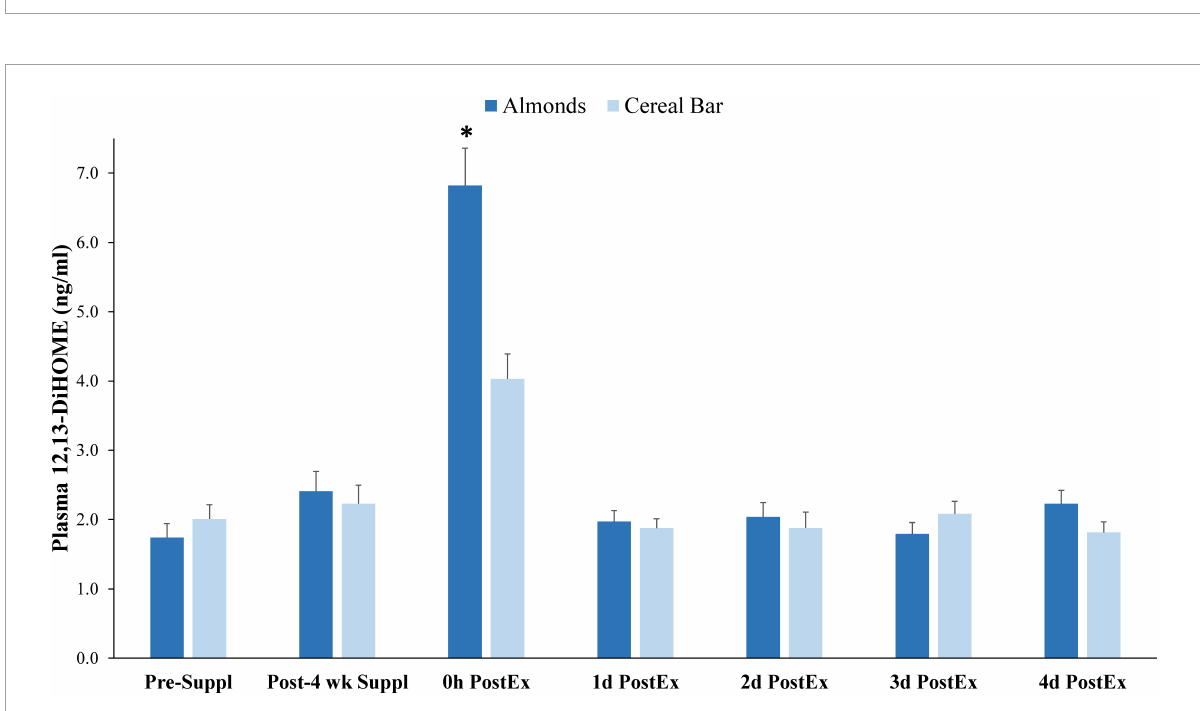
FIGURE5 Plasma 12,13-DiHOME data before and after 4-weeks supplementation, and immediately post 90 min eccentric exercise and in an overnight fasted state during 4 days of recovery (AL = almond, n = 33; CB = cereal bar, n = 31) (means ± SE). Time effect, p < 0.001, interaction effect, p < 0.001, q < 0.10. ∗ p = 0.000013, group contrast of the increase relative to pre-supplementation. Suppl, supplementation; PostEx, post-90 min eccentric exercise